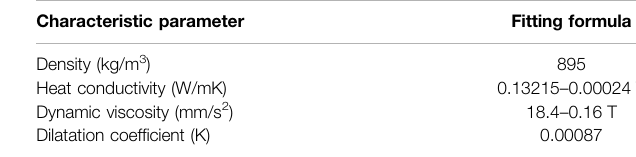
TABLE 2 | Insulating oil property